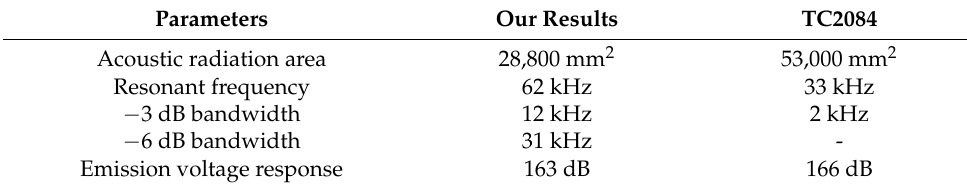
Table 4. Comparison of emission performance of underwater acoustic